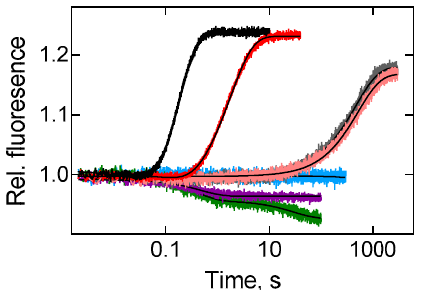
Figure 2. Inhibition of A-site binding kinetics. Time courses of BPY-labelled ribosomal complex (0.1 µM) interaction with ternary complex (1 µM) containing EF-Tu from E. coli (black trace) or T. thermophilus (red trace) compared to the reaction, inhibited by 30 µM tetracycline with EF-Tu from E. coli (grey trace) or T. thermophilus (pink trace), 150 µM kirromycin with EF-Tu from E. coli (green trace), a modified variant of EF-Tu His84Ala from E. coli (violet trace) or buffer TAKM 7 (blue trace). Each time course reflects the average of 5 to 7 technical replicates. S.e.m. associated with the kinetics were calculated by the GraphPad Prism software.